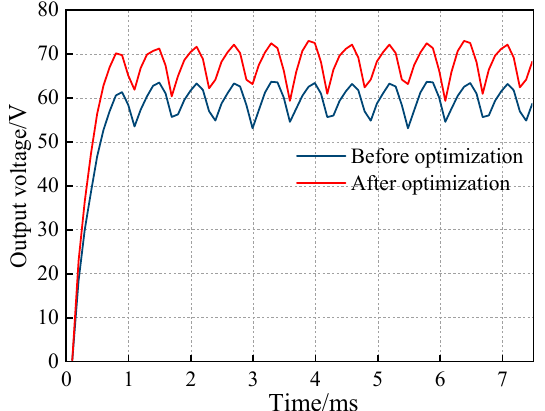
Figure 17. Comparison of the no-load induced EMF of claw pole rotor before and after optimiza- tion. ( a ) Comparison of the no-load induced EMF curves; ( b ) comparison of the no-load induced EMF harmonic distribution.